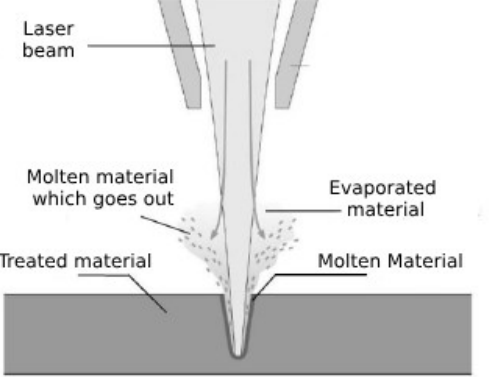
Figure 2. Schematic representation of laser material processing application